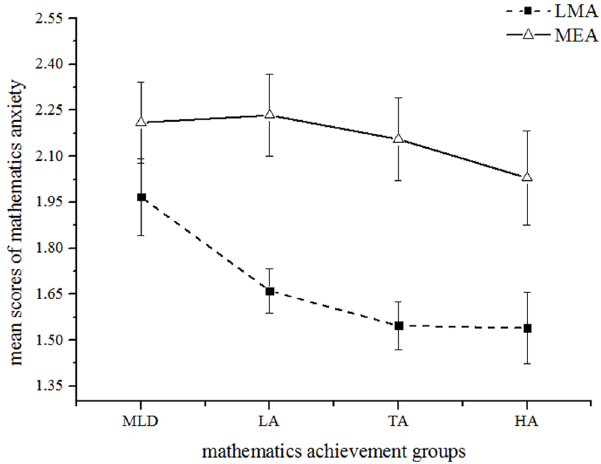
Fig 5. Mean scores for the dimensionalities of MA of four mathematics achievement groups. MLD = mathematical learning difficulty, LA = low achieving, TA = typical achieving, HA = high achieving. LMA = learning mathematics anxiety, MEA = mathematical evaluation